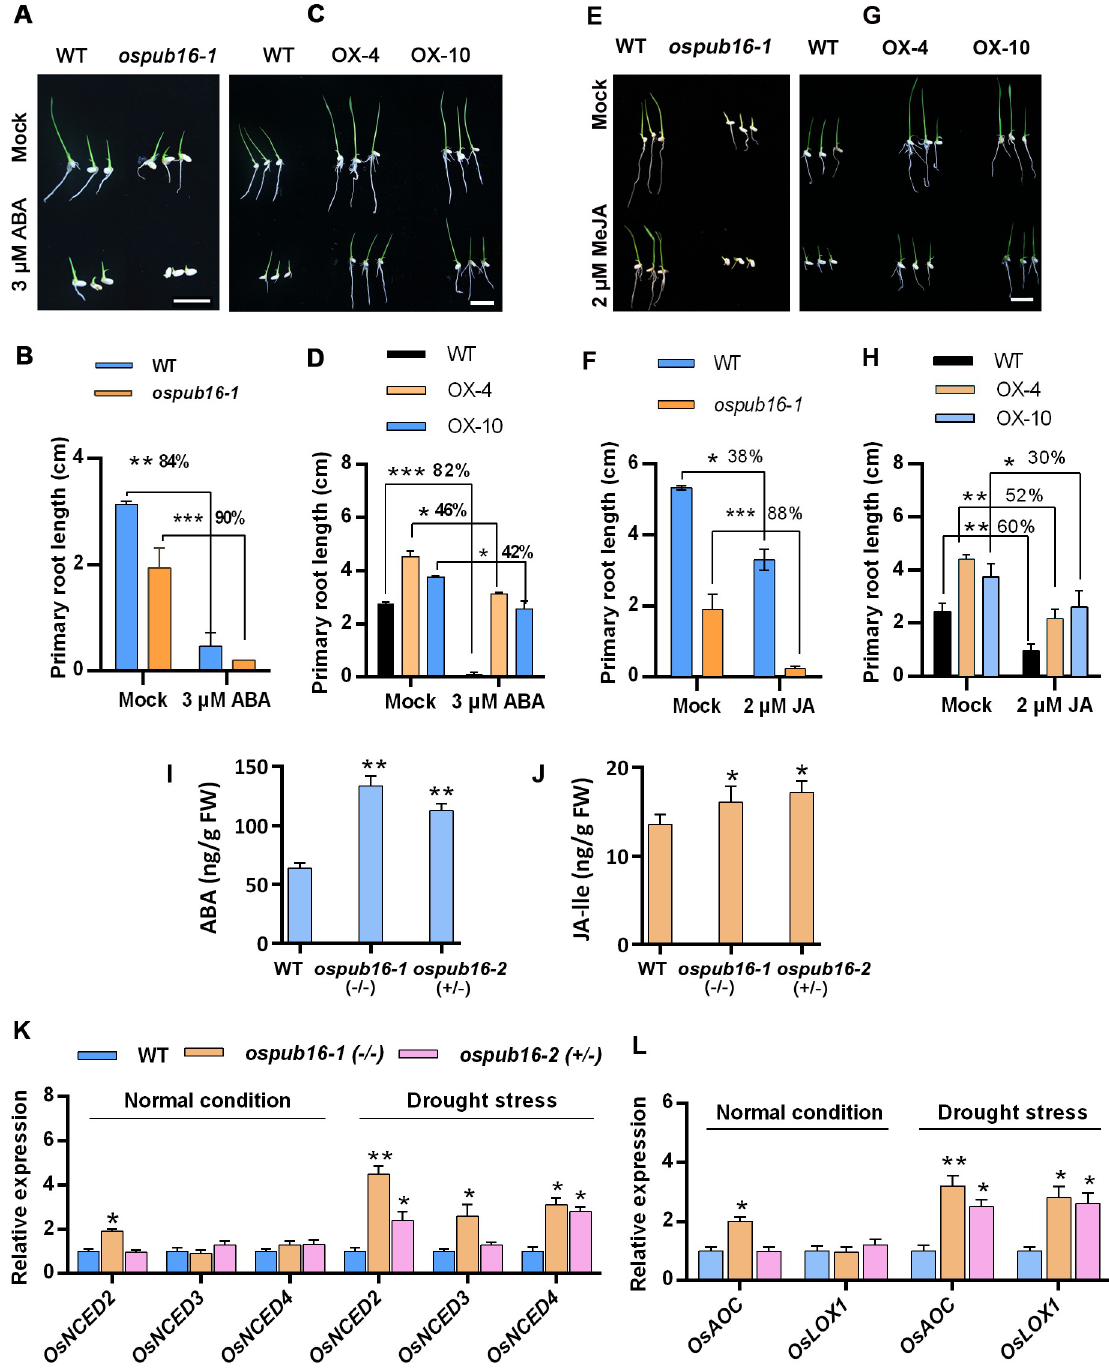
Fig 4. OsPUB16 reduced the ABA and JA response in rice. (A, C) Images showing the responses of ospub16-1 mutant, wild type (WT, Nipponbare) and OsPUB16 overexpression lines (OX-4 and OX-10) to exogenous ABA. Scale bars, 2 cm. Uniformly germinated seeds were grown on 1/2MS medium supplemented with or without 3 μ M ABA for 3 days. (B, D) Measurement of the primary root length of plants as described in (A) and (C), respectively. Data are means ± SD ( n = 20). (E, G) Images showing the responses of different genotypes to exogenous MeJA. Scale bars, 2 cm. Uniformly germinated seeds were grown on 1/2MS medium with or without 2 μ M MeJA for 3 days. (F, H) Measurement of the primary root length of plants as described in (E) and (G), respectively. Data are means ± SD ( n = 15). (I, J) ABA and JA-lle content in WT and ospub16 mutants after exposed to water deficit stress. Two-week-old plants were subjected to water deficit stress for 5 days, and leaves were collected for measurement of bioactive ABA and JA-lle content. Data are means ± SD ( n = 3). (K, L) Expression of key genes involved in ABA (K) and JA (L) biosynthesis in ospub16 mutants and WT under normal conditions and drought